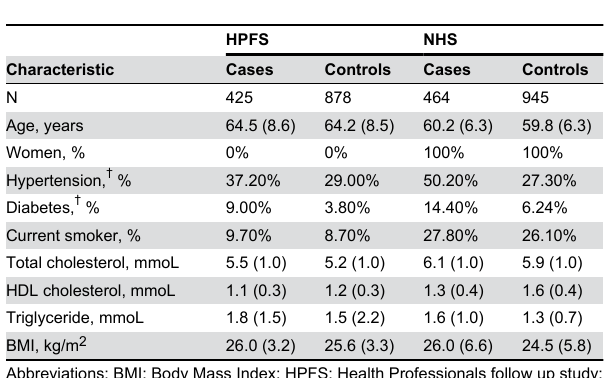
Table 1. Clinical parameters for the case control cohorts in the NHS and HPFS.